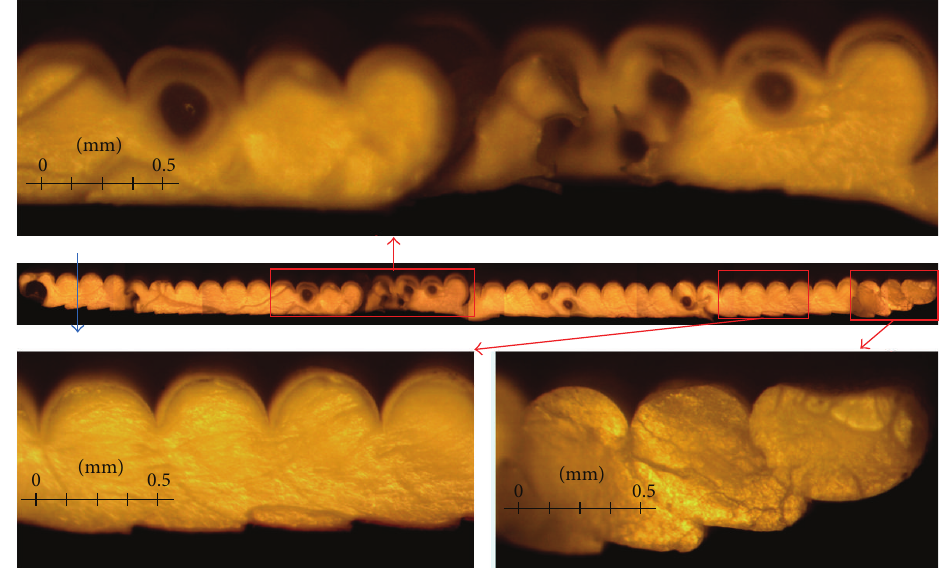
Figure 7: Break surface of a rectangular monolayer specimen after tensile testing (blue = build direction).